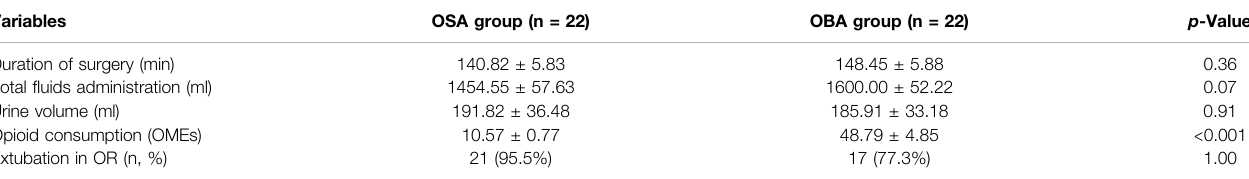
TABLE 2 | Intraoperative data of patients.